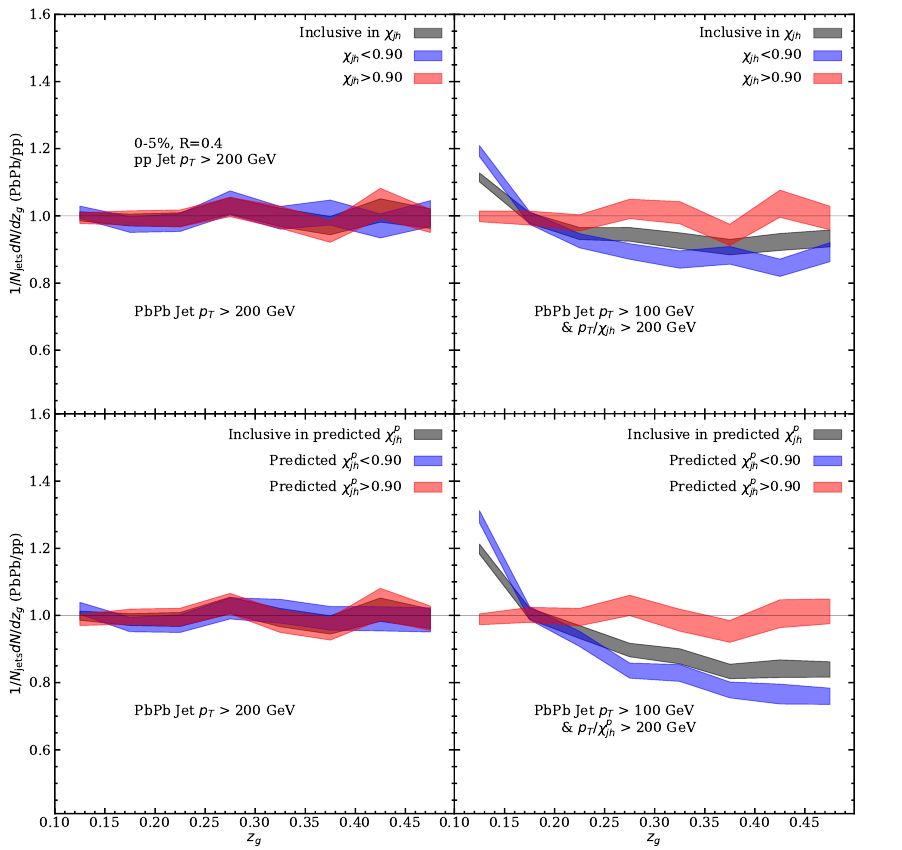
Figure 15 . Results comparing the z g ratio between PbPb and pp for the true χ jh (top row) and predicted χ p (bottom row), and the FES (left column) with the IES (right jh